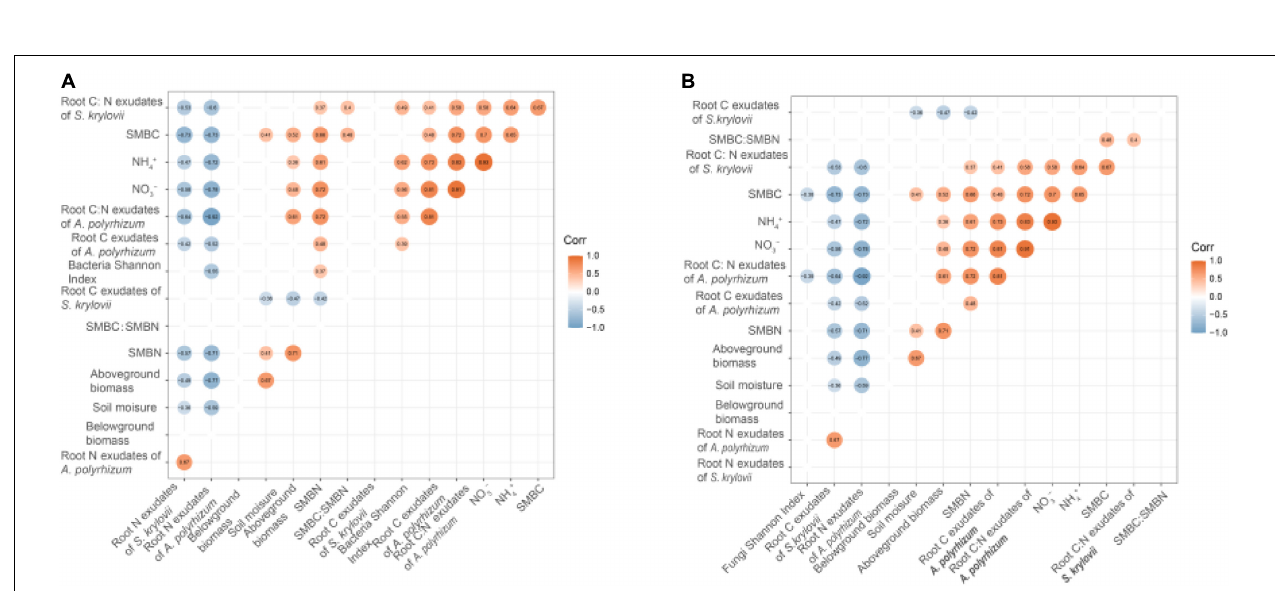
FIGURE 2 | Pearson correlations among bacterial Shannon index (A) , fungi Shannon index (B) , aboveground biomass, belowground biomass, soil moisture, soil microbial biomass carbon (SMBC), soil microbial biomass nitrogen (SMBN), SMBC:SMBN, NO 3 – , NH 4 + , root C exudates of Stipa krylovii , root N exudates of S. krylovii , root C: N exudates of S. krylovii , root C exudates of Allium polyrhizum , root N exudates of A. polyrhizum, and root C: N exudates of A. polyrhizum . The number represents the correlation coefficient. Coefficients that are not correlated have been hidden. Different treatments: Con: Control; RR: Rainfall reduction; RA: Rainfall addition; N: Nitrogen addition; RR + N: Rainfall reduction and Nitrogen addition; RA + N: Rainfall addition and Nitrogen addition.